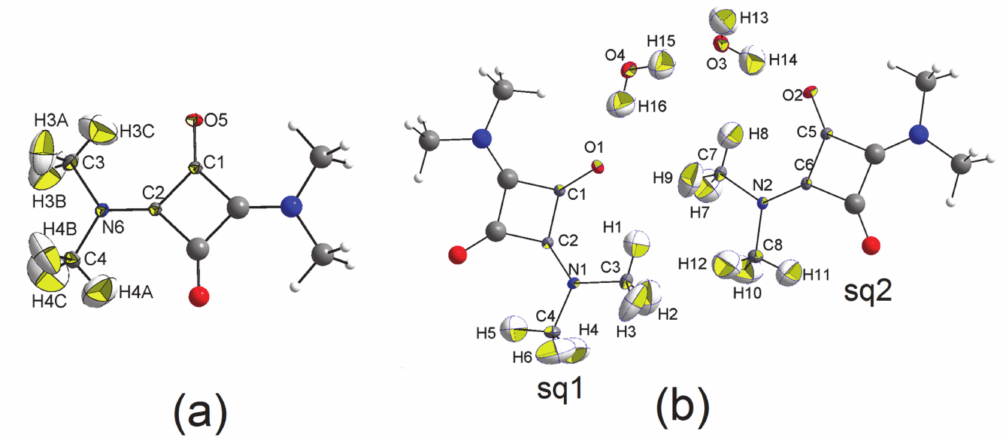
Figure 2. ( a ) SQ at T = 18 (1) K, with symmetry-independent atoms belonging to the asymmetric unit labelled with their numbering scheme. Thermal ellipsoids were drawn (also for the asymmetric unit only) at the 90% probability level. Anisotropic thermal ellipsoids of H atoms were estimated by the ADPH program [30]. ( b ) Same as ( a ) for SQDH at T = 20 (1) K. The two symmetry-independent molecules are labelled as “sq1” and “sq2” (see